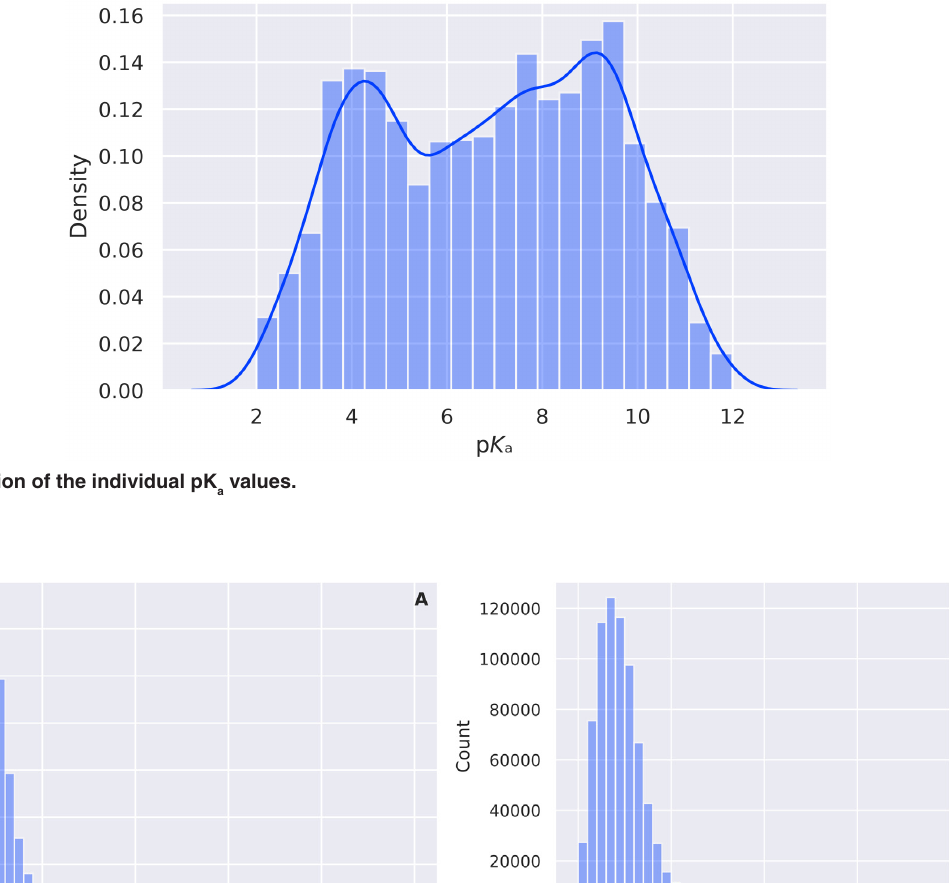
Figure 2. ( A ) Pairwise comparison between the training set and the Novartis test set (Fingerprint: 4096 bit MorganFeatures radius=3). ( B ) Pairwise comparison between the training set and the test set compiled by manual curation (Fingerprint: 4096 bit MorganFeatures